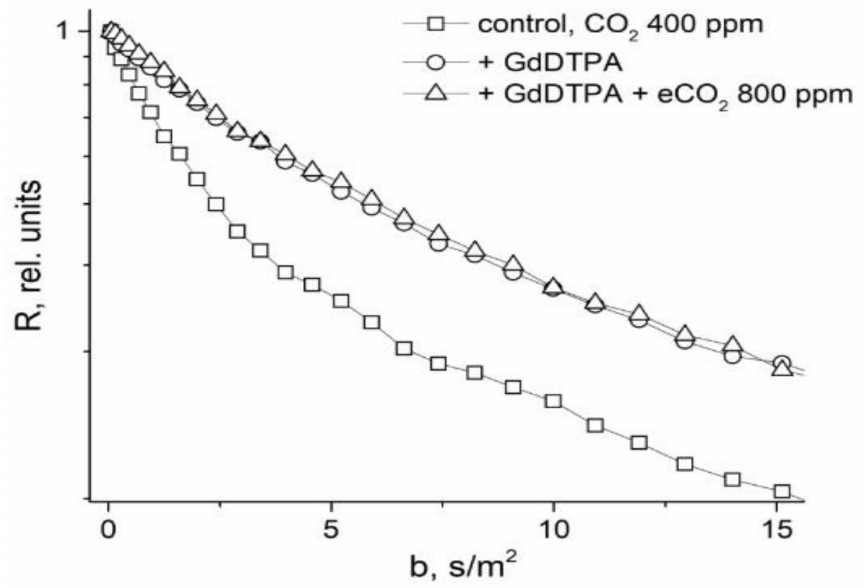
Figure 23. Diffusional decays for roots of intact maize plants in control (ambient CO 2 400 ppm) (open squares), after 2 h of roots incubation in 25 mM solute of GdDTPA (open circles) and following an increasing CO 2 concentration to 800 ppm (open triangles), ( b = γ 2 δ 2 g 2 t d )